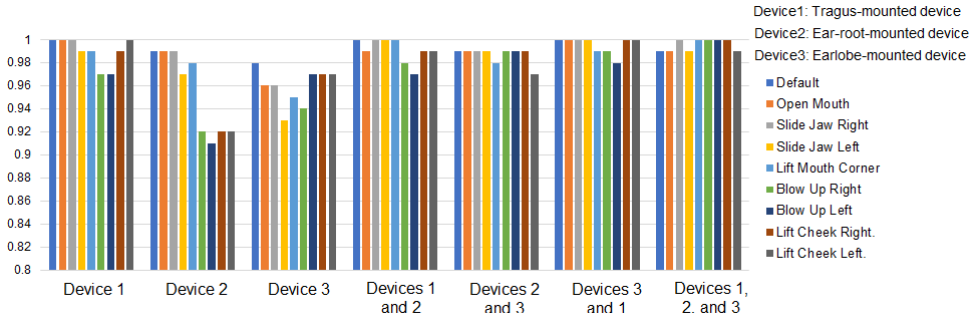
Figure 10. The results of each gesture in Evaluation 1 using nine gestures. The average F-value for each device pattern.